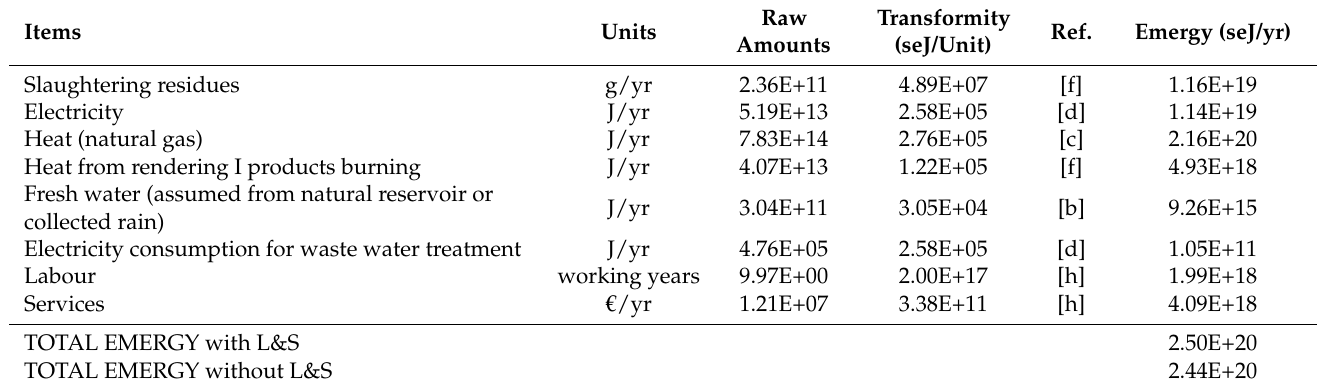
Table 4. Emergy table of rendering II.